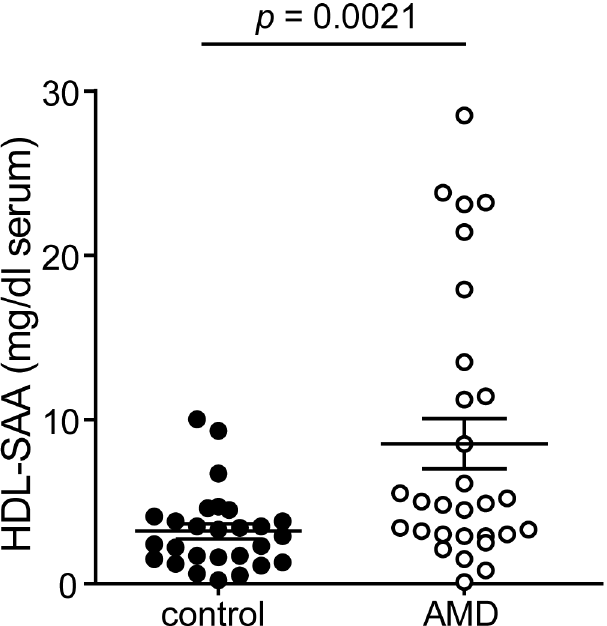
Fig 2. Serum amyloid a levels are increased in AMD patients. Serum amyloid A (SAA) levels in apolipoprotein B (apoB)-depleted sera was quantified by ELISA. Values shown represent means of four independent